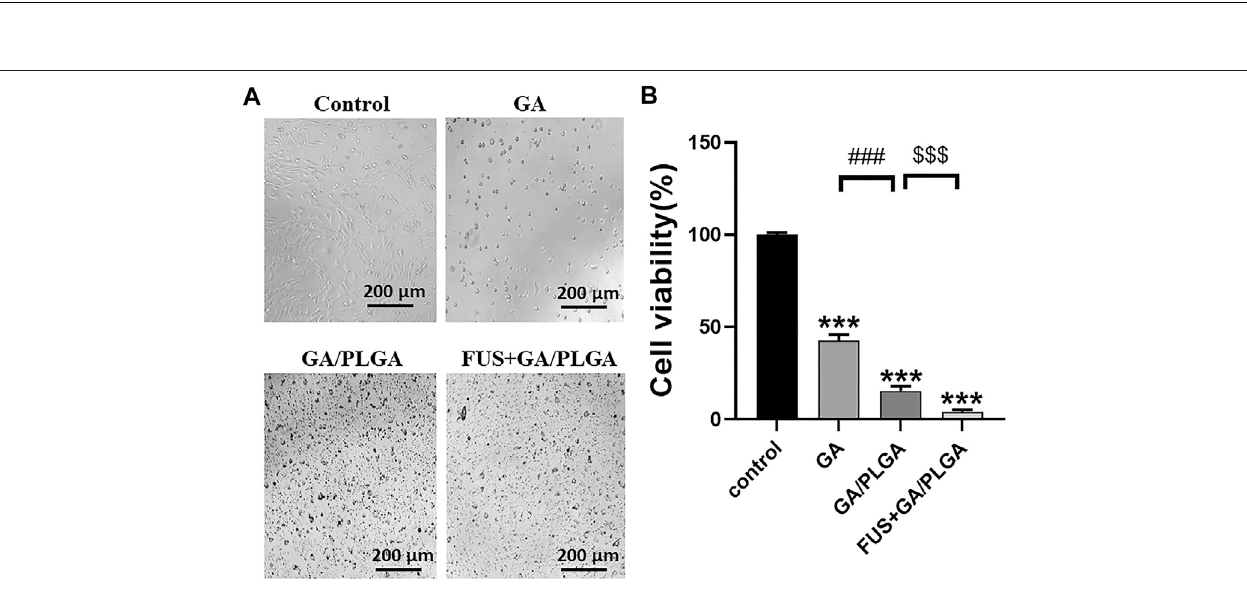
FIGURE 3 | (A) Growth status of U251 cells. As the concentration of GA increases, the survival state of the U251 cell line gradually deteriorates. (B) Cell viability of U251 cells. After different concentrations of GA were incubated with U251 cells, cell viability of each group was detected by the CCK-8 reagent. When the GA concentration is 1.5 μ mol/L, the cell viability is 56.99 ± 3.95% (** p < 0.01 versus “ 0 μ mol/L ” group).